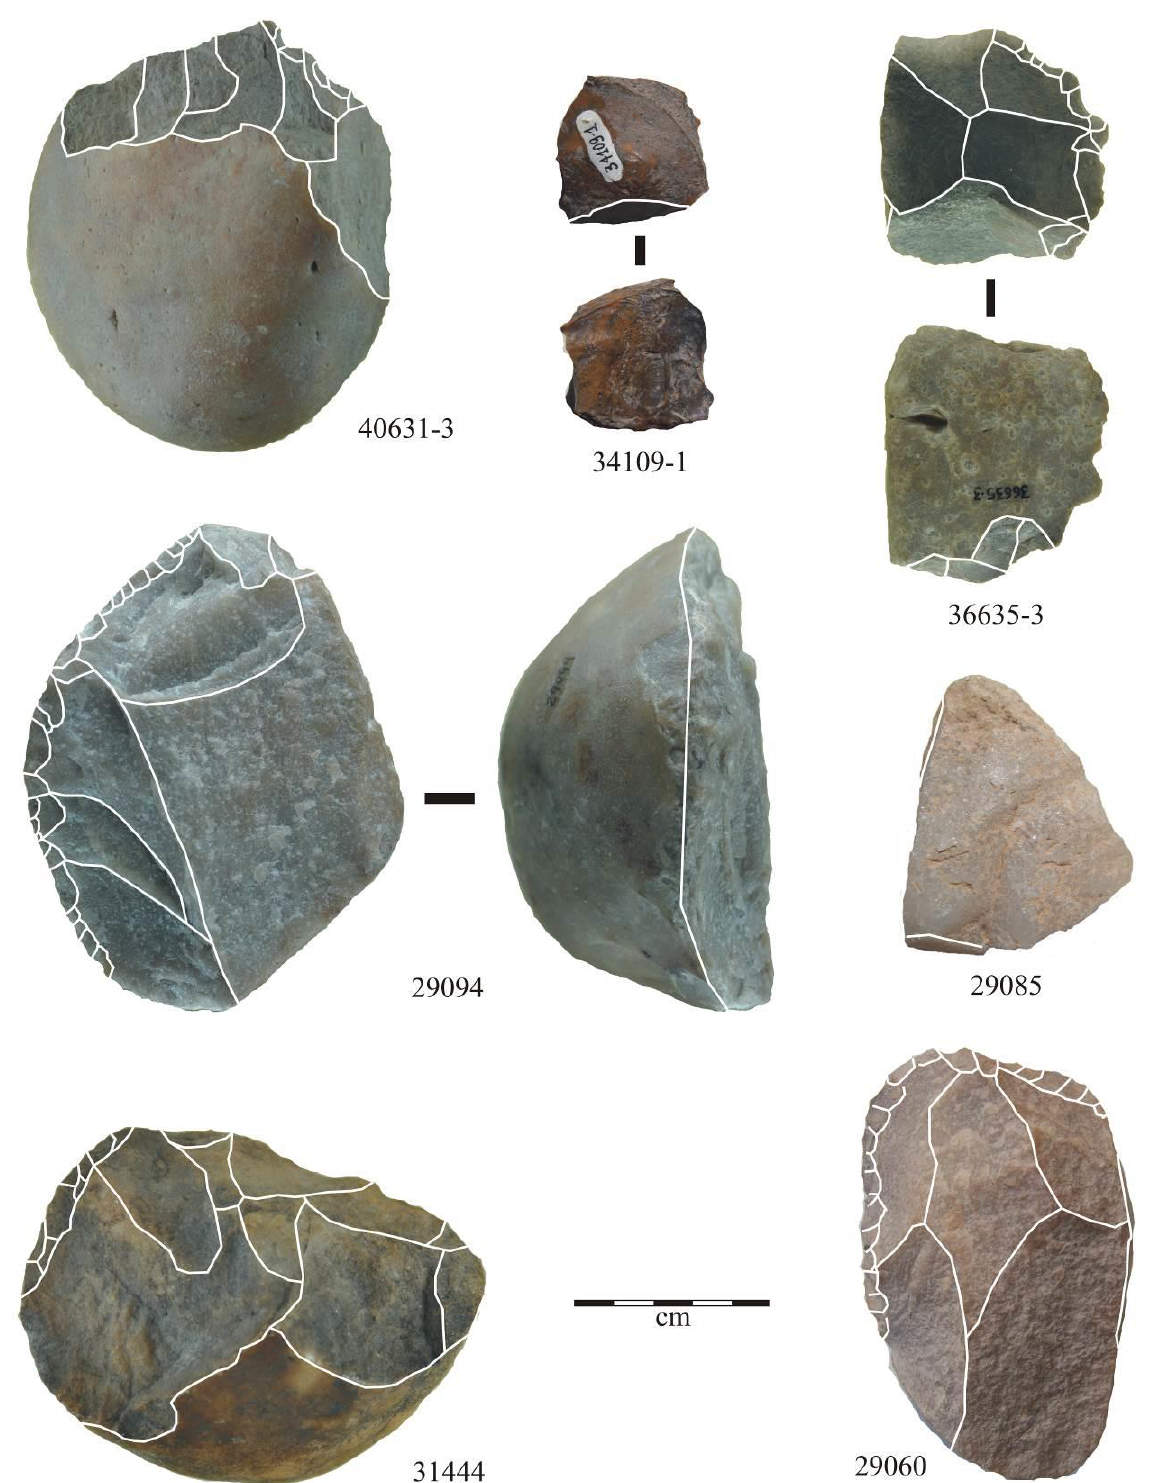
Figure 10. Artifacts from lower Holocene of Sitio do Meio, Serra Talhada I phase. Numbers refer to FUMDHAM inventory. 40631-3: chopper, 34109-1: flake, 36635-3: denticulate, 29094: simple scraper, 29085: flake, 31444: chopper, 29060: convex scraper. (Photo by L.